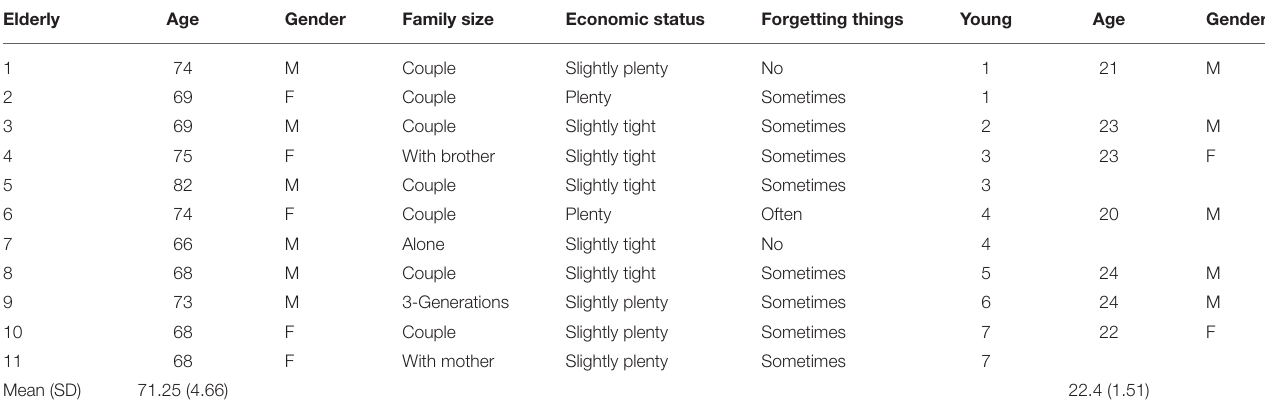
TABLE 1 | Participants